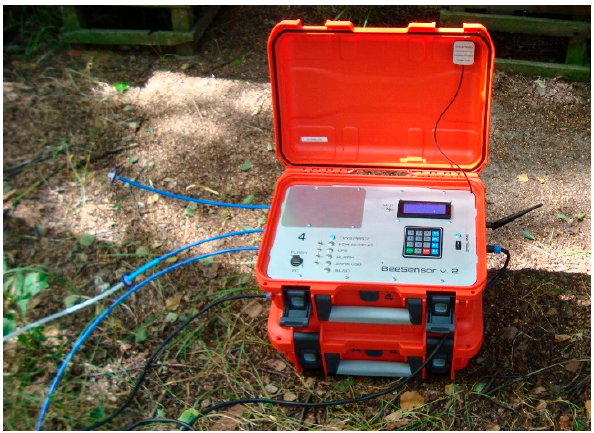
Figure 1. Gas sensing device which was used in our experiments.